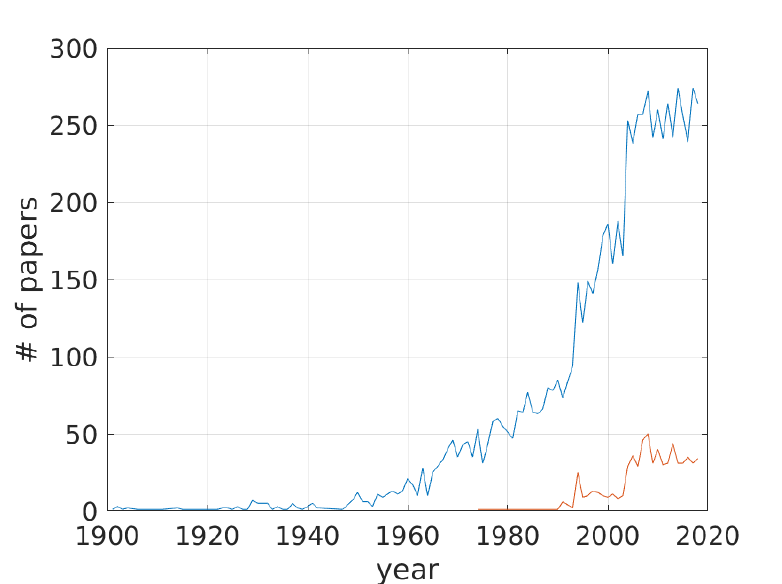
Figure A1. Number of papers about magnetostrictive actuators (red line) compared with papers on magnetostriction (blue line) over